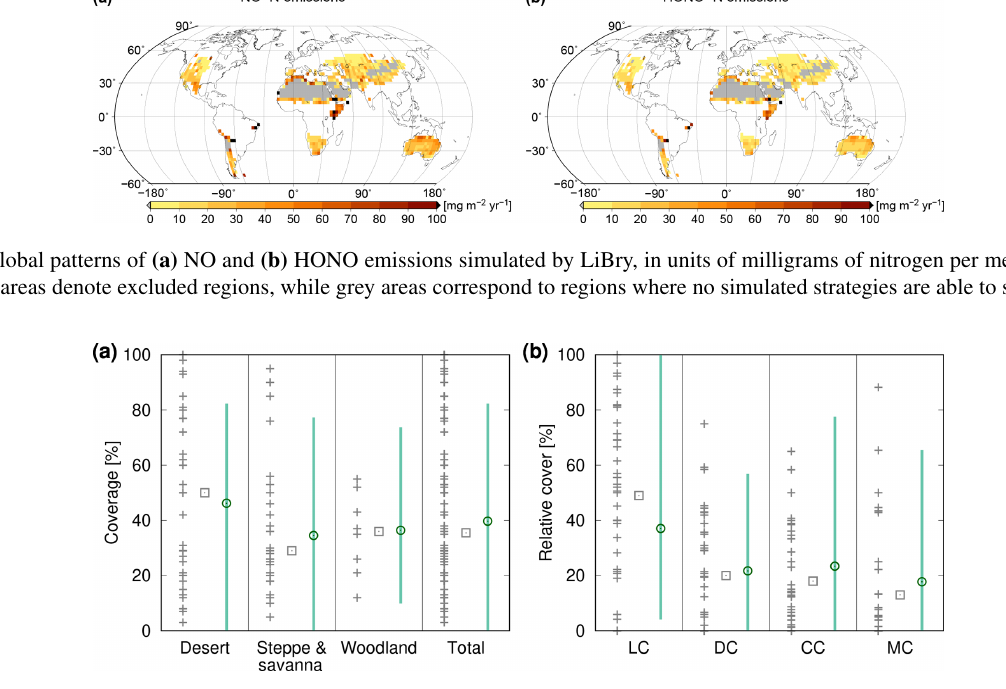
Figure 8. Comparison of biocrust cover estimated by LiBry to field observations (a) for three different biomes and the total study region and (b) for four different biocrust types. The abbreviations on the x axis stand for light cyanobacteria-dominated (LC), dark cyanobacteria- dominated (DC), chlorolichen-dominated (CC), and moss-dominated (MC) biocrusts. The grey crosses show field measurements of biocrust cover from various studies, which are listed in the Appendix in Tables A1 and A2. Grey rectangles correspond to the median values of all field measurements in a column. The green circles show (a) average simulated biocrust cover for all points of the model grid belonging to a biome and (b) average relative cover for all points of the study region, separated into biocrust types. Green bars denote the range of (a) cover and (b) relative cover of all considered grid points. Note that regions where no strategies were able to survive in the model are excluded from the